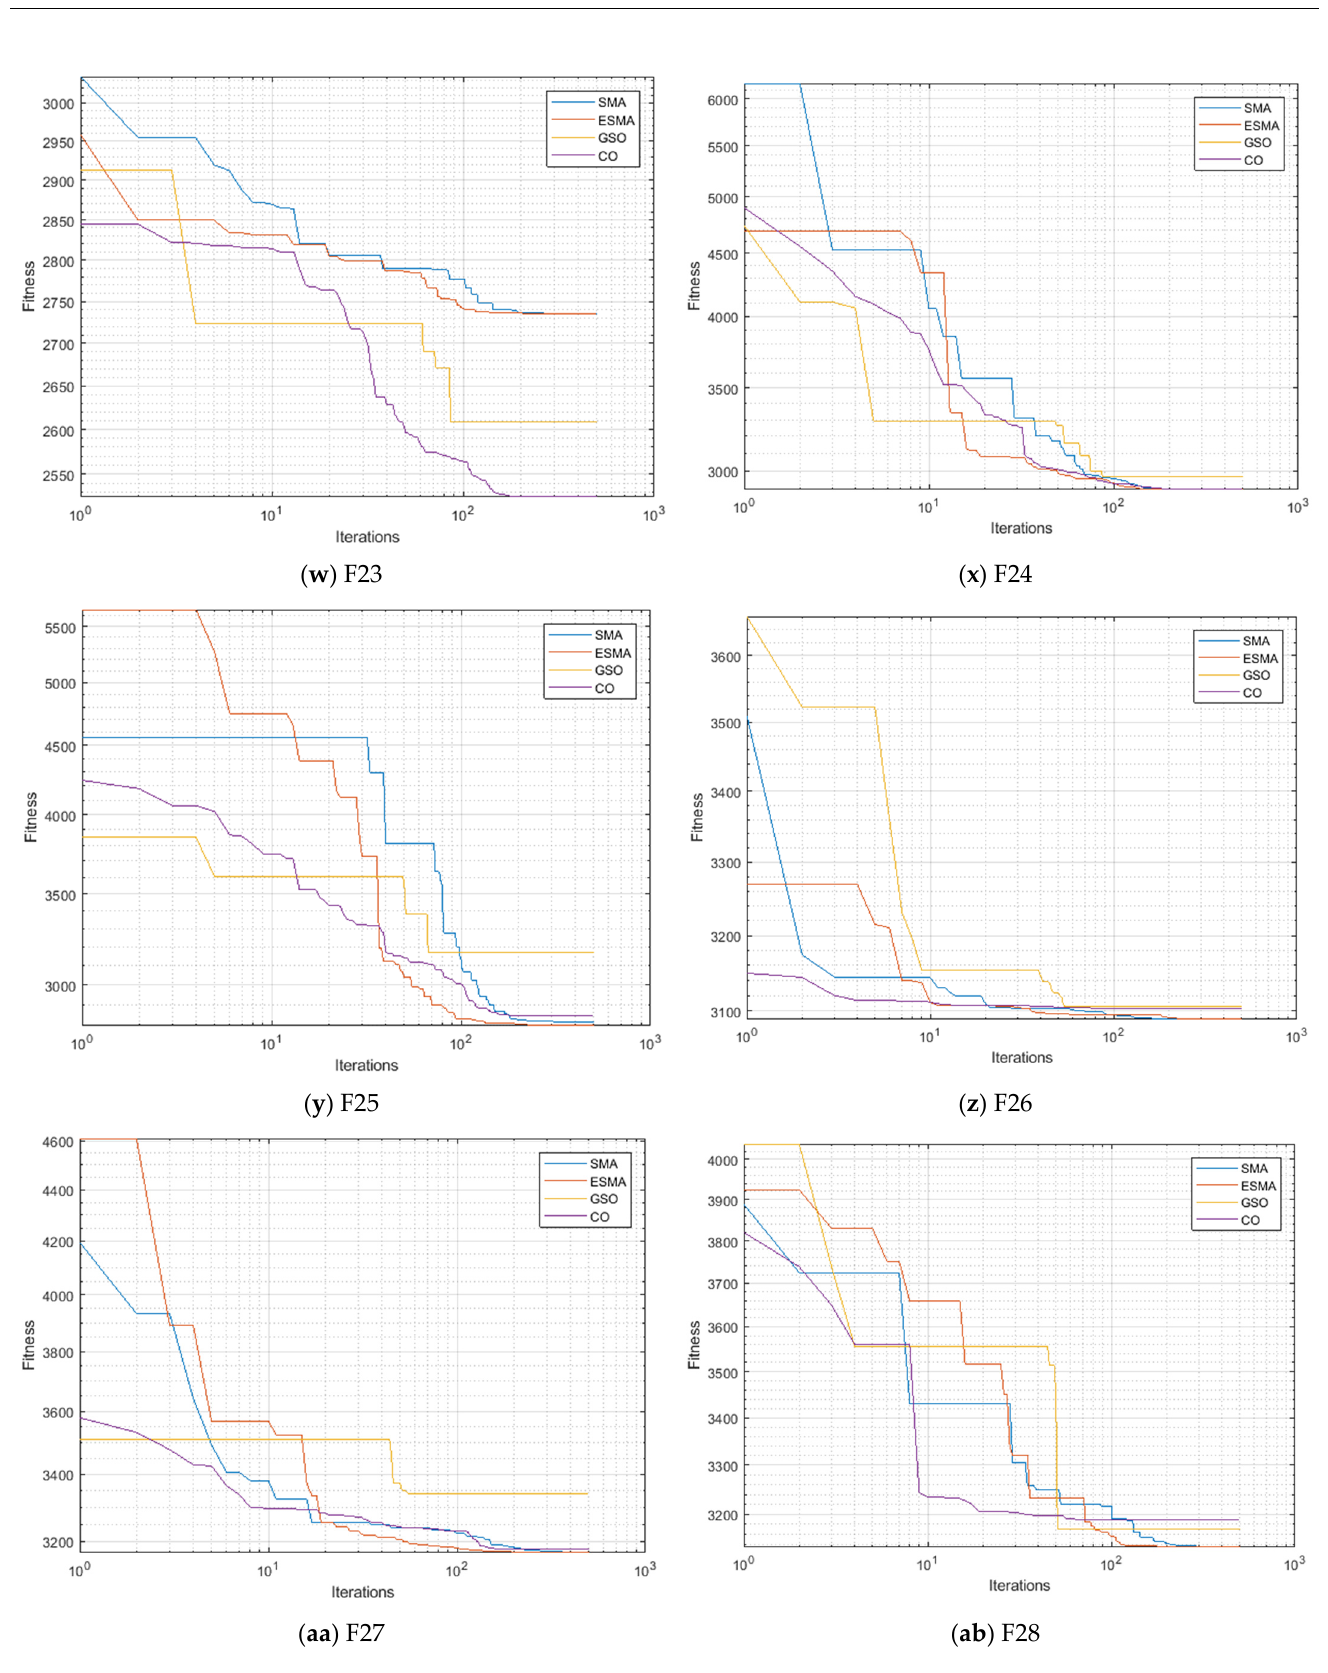
Figure 4. Convergence features of the comparative algorithms for the 28 benchmark functions. From both tables, the proposed ESMOA shows great e ff ectiveness and robustness over the original SMOA, GSO, and CO. Compared to the original SMOA, the proposed